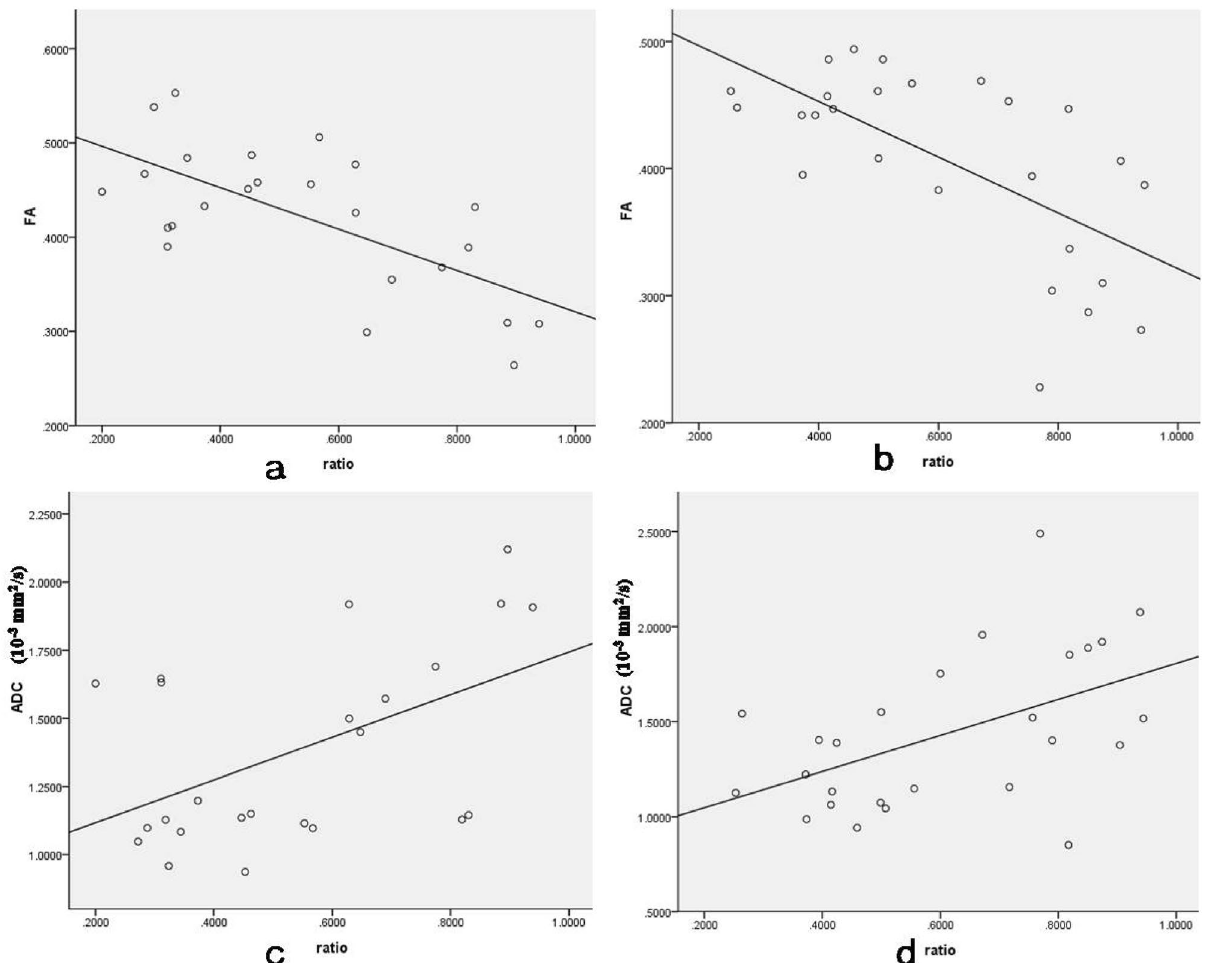
Figure 4. The association between size of syrinx cavity and FA values at C5 ( a ) and C6 ( b ) was negative. However, about ADC values (mm 2 /s) the association was positive ( c , d ).